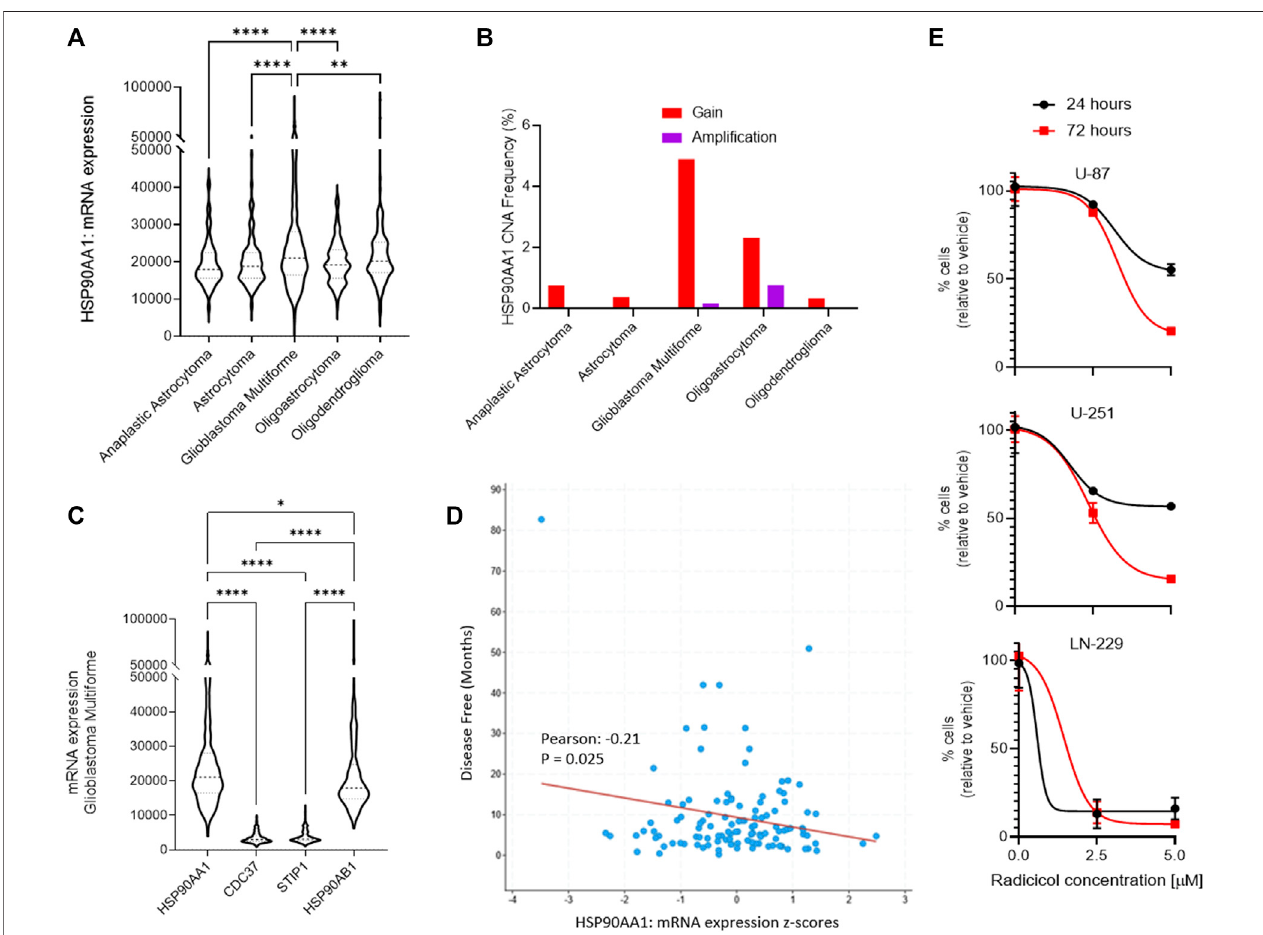
FIGURE 1 | Role of Hsp90 in glioblastoma multiforme (GBM) across CNS tumors. (A) HSP90AA1 mRNA expression (RNA Seq V2 RSEM) [log 2 (value + 1)] compared across fi ve clinical studies (cBioPortal). **p < 0.01, ****p < 0.0001 analyzed by ordinary one-way ANOVA with Tukey ’ s multiple-comparison test. (B) Copy numberalteration (CNA)evaluatedacrosssevenclinicalstudies(cBioPortal). (C) GBMclinicaldatasetsand TCGAdatawerequeriedtocomparemultipleHsp90-related chaperone and co-chaperone gene expressions by mRNA. *p < 0.05, ****p < 0.0001 analyzed by ordinary one-way ANOVA with Tukey ’ s multiple-comparison test. (D) Dotplotcomparing disease-free survivalwithHsp90mRNA geneexpression fromtwoGBMclinicaldatasets(cBioPortal).The lineindicatessimplelinearregression. Pearson ’ s coef fi cient is statistically signi fi cant. (E) Cell kill curves of three high-grade glioma/GBM cell lines following treatment with the Hsp90 inhibitor, radicicol, for the indicated amount of time and concentration. N (cid:2) 3 in biological